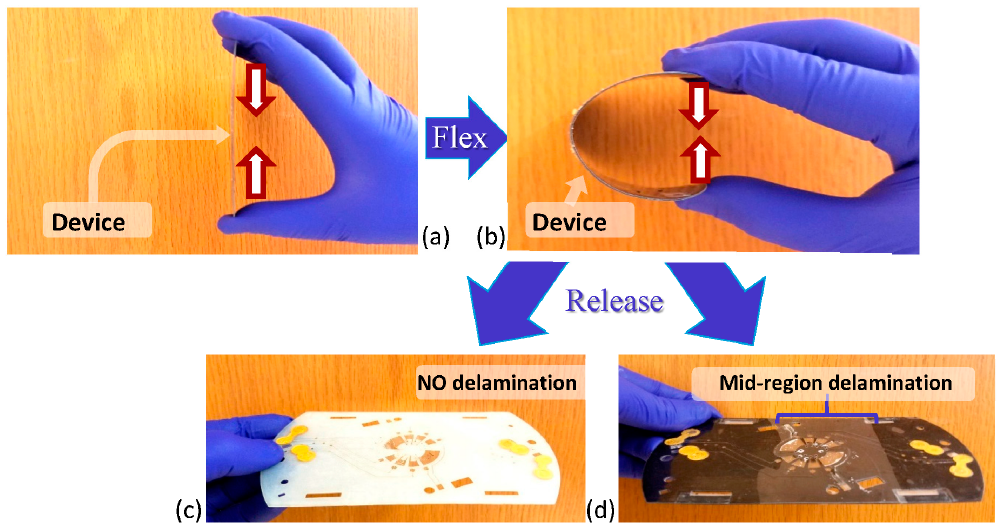
Figure 2. Images of ( a ) Device before flex; ( b ) Device during flex; and ( c ) A device post-flex, which was